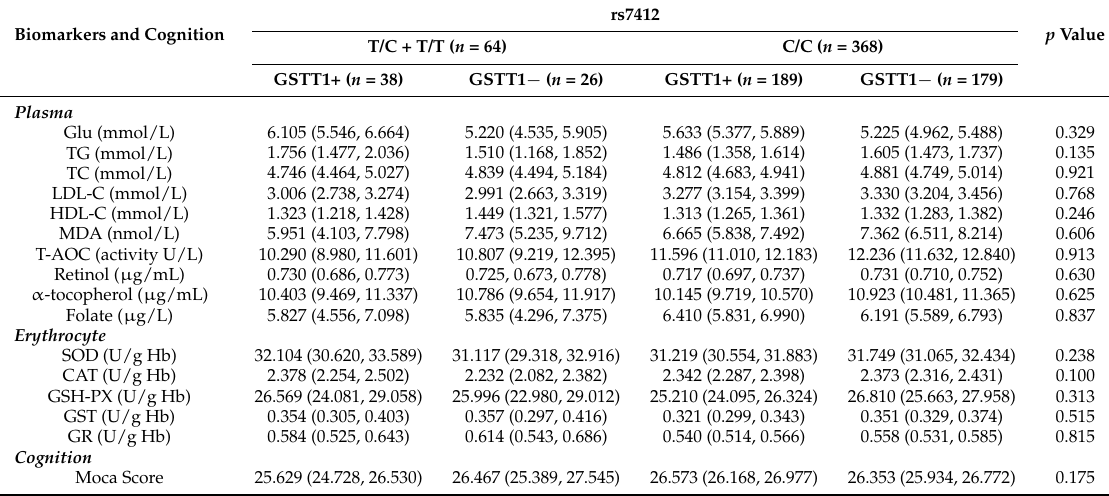
Plasma, erythrocytes parameters and cognition according to APOE SNP rs7412 and GSTT1